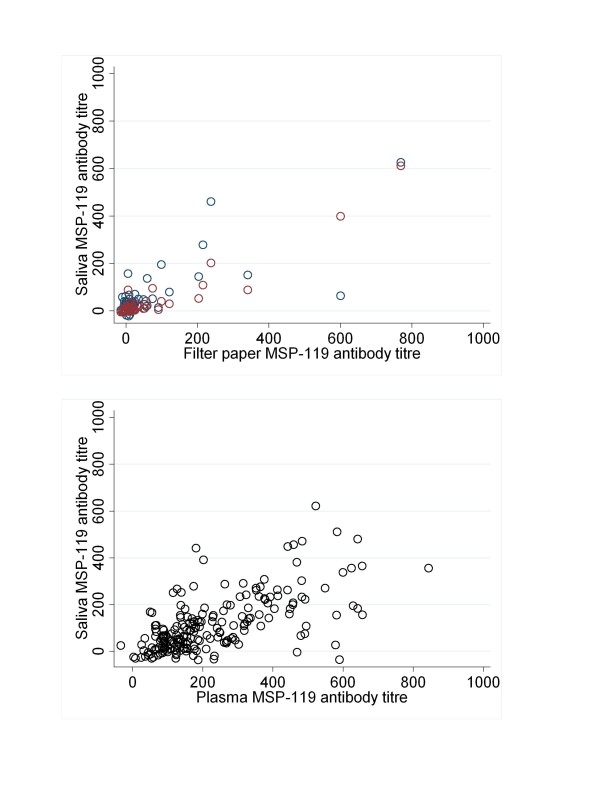
Scatterplots showing relationship between paired antibody titres from plasma and saliva to P. falciparum merozoite surface antigen MSP-119 in a) Tanzania and b) The Gambia. In plot a) open red circles represent measures by OraSure and blue circles by OraCol.